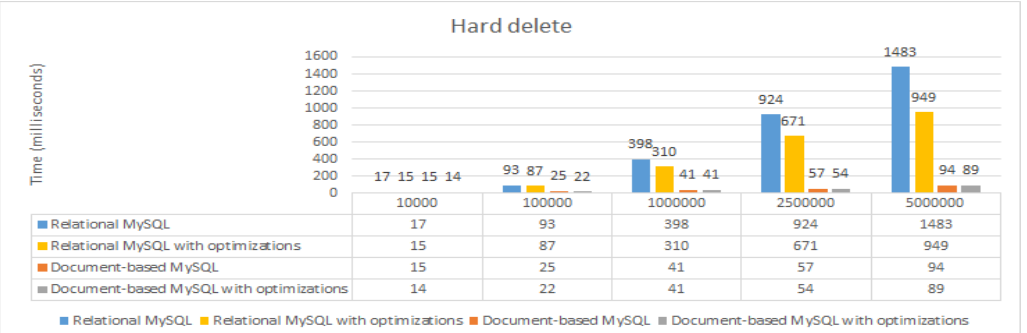
Figure 13. Performance time (ms) for the hard delete operation.